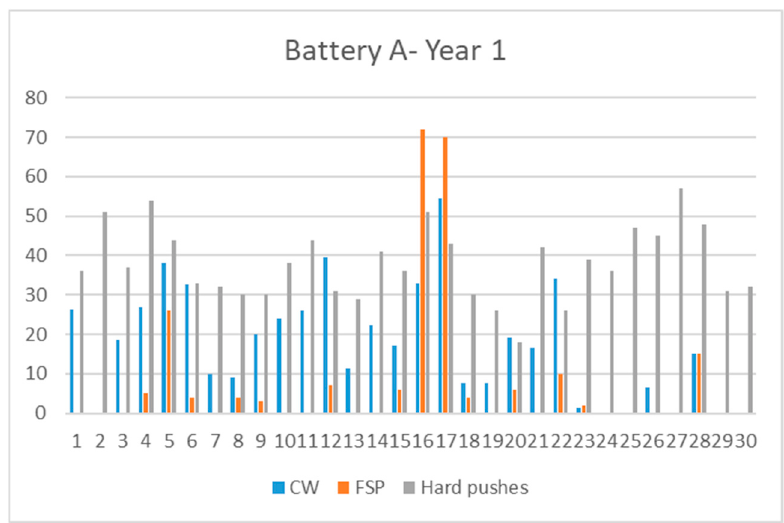
Figure 8. Hard pushes and refractory repairs battery A, year 1.